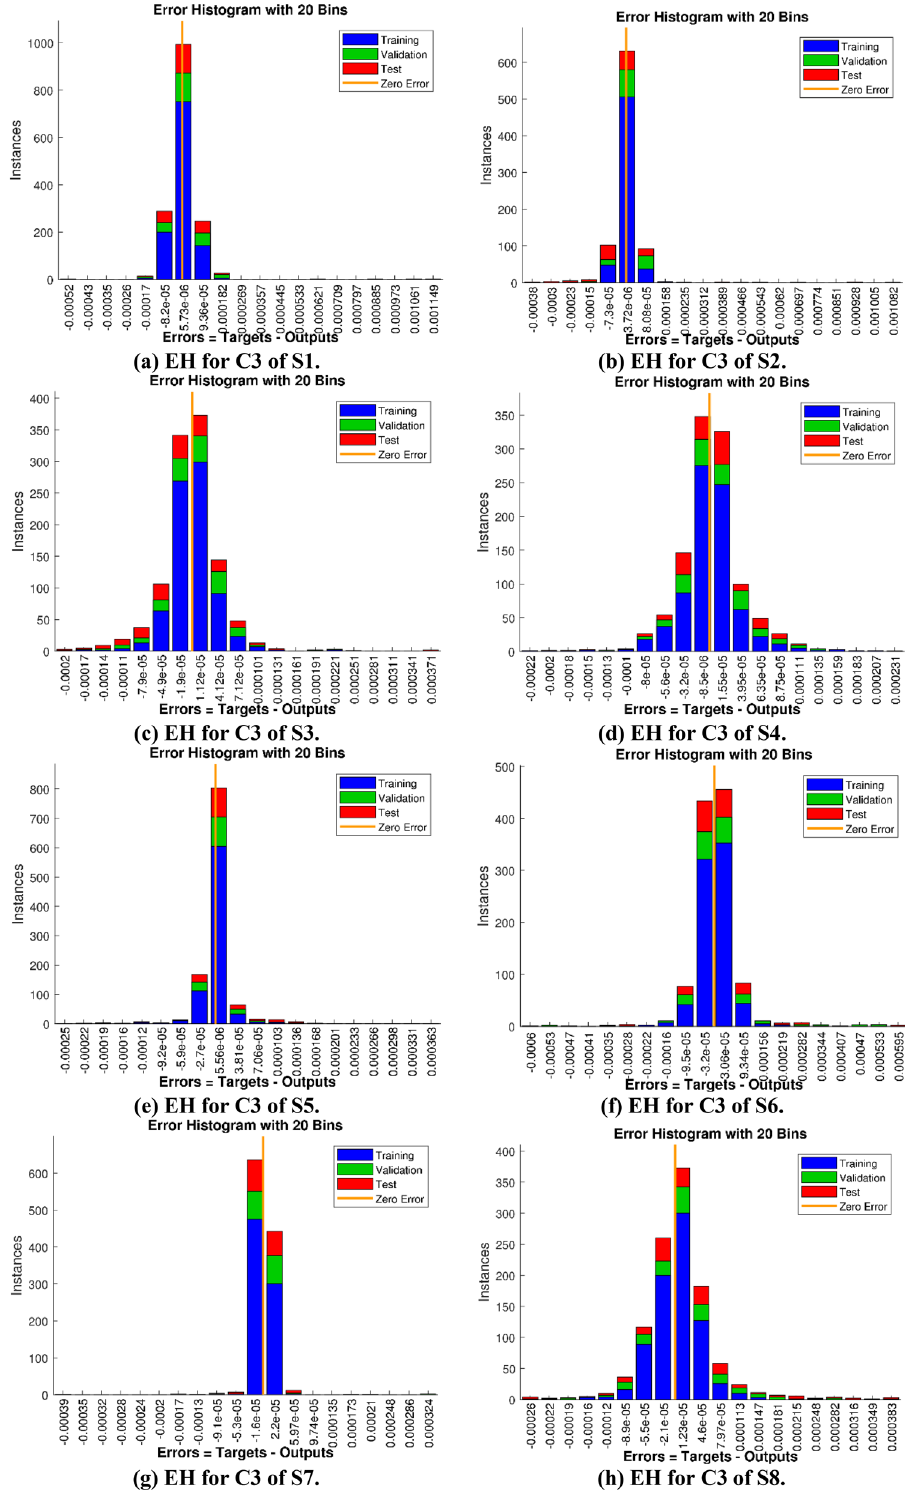
Figure 8. Illistration via Error histograms(EH) for C3 of all eight